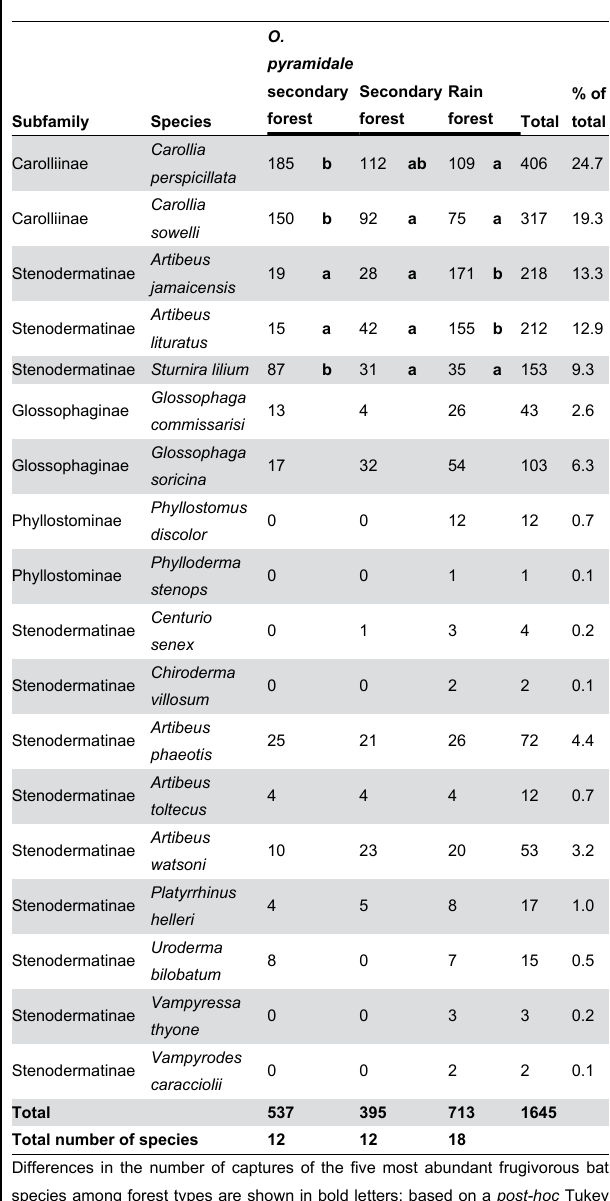
Table 1. Number of captures per frugivorous bat species and subfamily in Ochroma pyramidale managed forests, secondary forests and rain